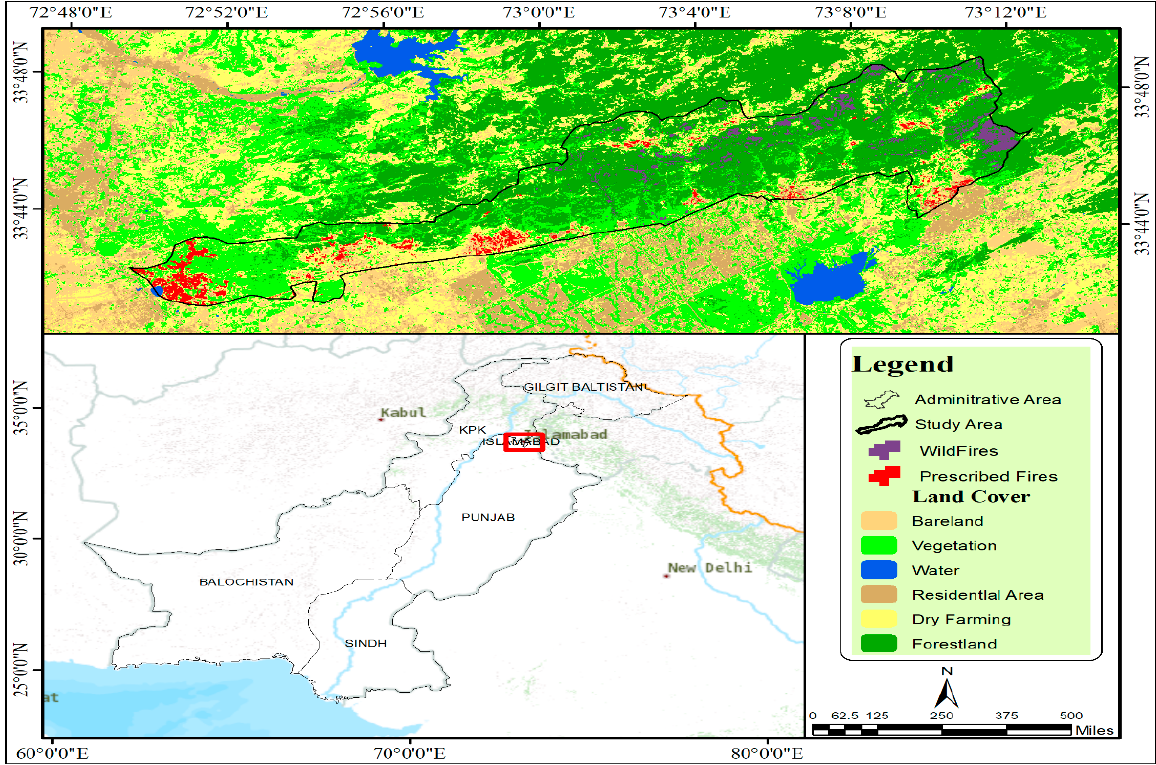
Figure 1. Occurrence of wildfires and prescribed fires during the period 2015–2020 in the Margalla Hills of Pakistan.